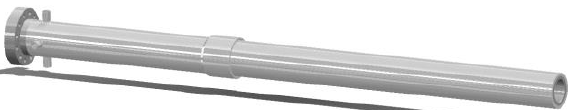
Fig. 5. Temperature distribution for 50-mm